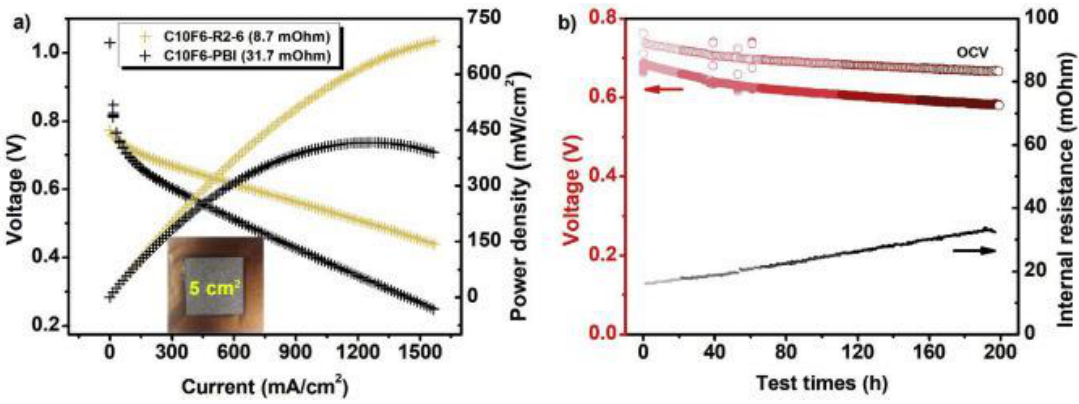
Figure 4. Outcomes of the crosslinked fluorinated PBI (F6-PBI) with unrestricted –NH sites ( a ) and the change in OCV of the membrane during a 200 h durability test, under 160 ◦ C, and in an anhydrous state ( b ) [73].